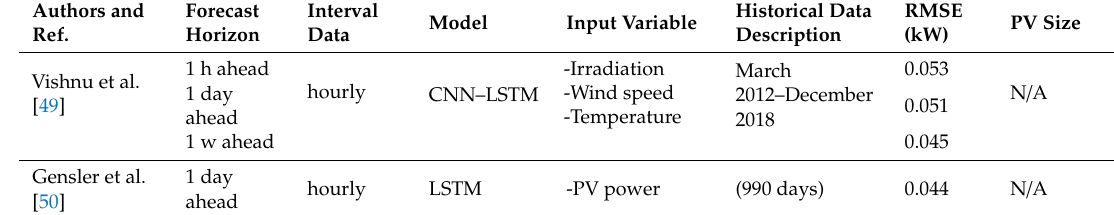
Table 4. PV power